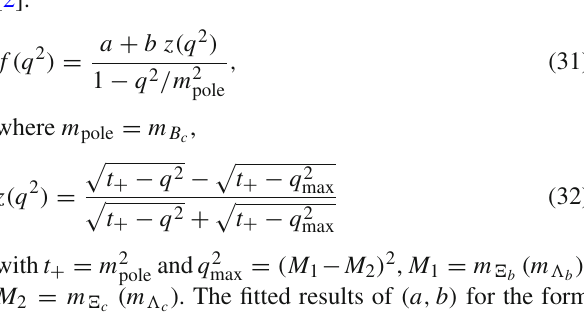
Table 2 The quantitative criteria of the pole dominance and OPE